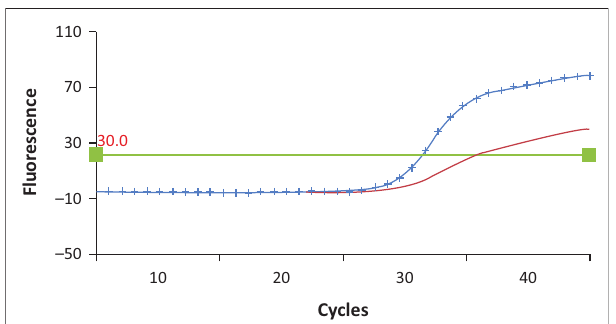
FIGURE 1: An amplification curve showing results with 0.4 µM wild-type and 0.4 µM mutant probes. Mutated allele curve with no markers, wild-type allele curve with crosses.